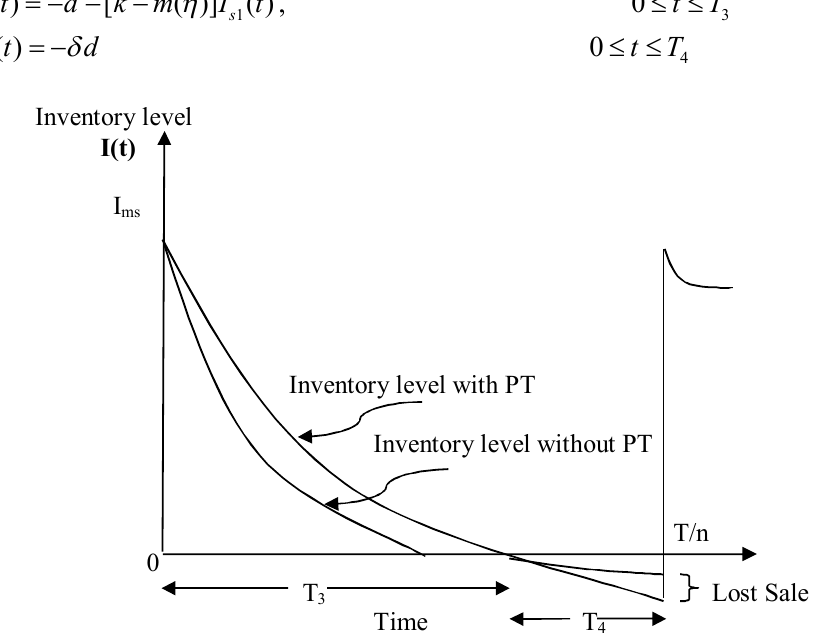
Fig. 2. The graphic representation of inventory model for